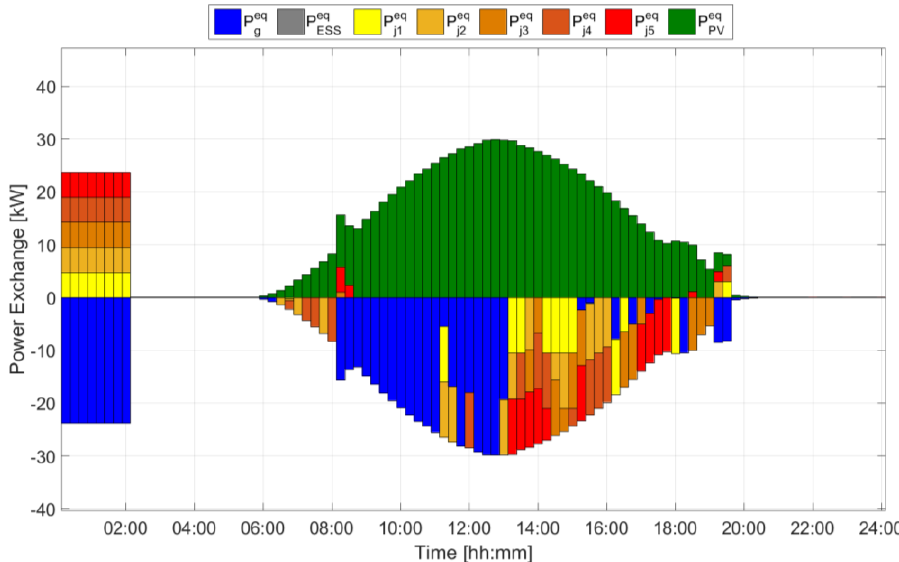
Figure 10. Microgrid power balance on the sunny day.